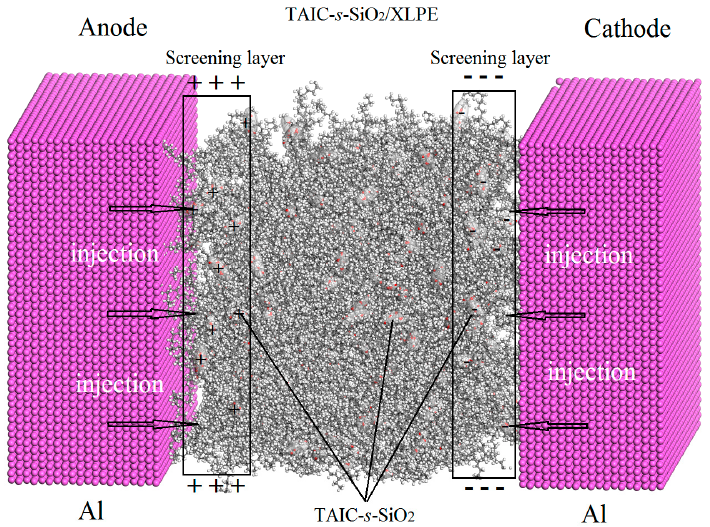
Figure 13. Schematic Coulomb potential shielding mechanism for suppressing the space charge accumulations in TAIC- s -SiO 2 /XLPE nanocomposites under DC electric field.